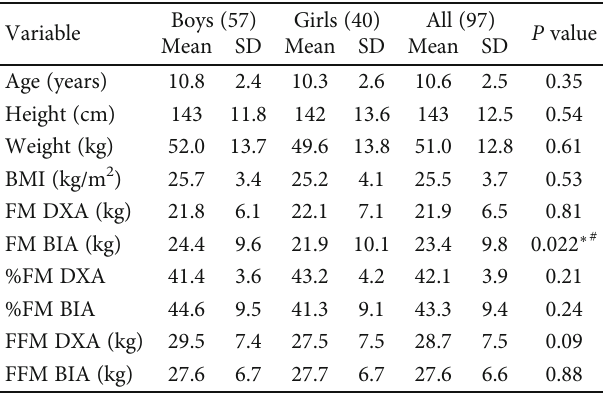
Table 2: Mean (SD) di ff erence and 95% CI between the measurements made by DXA and BIA.